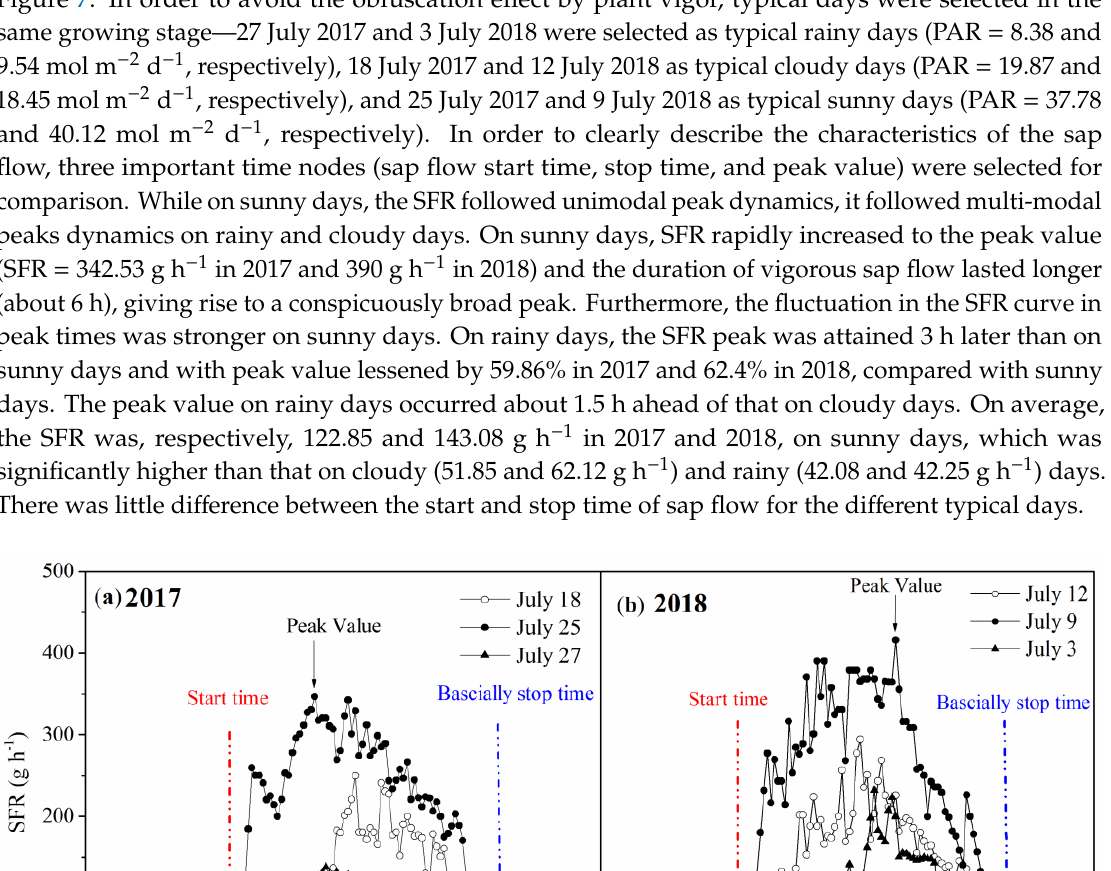
Figure 6. Plots of relationship between hourly sap flow rate (SFR) and environmental factors—( a ) photosynthetically active radiation (PAR), ( b ) vapor pressure deficit (VPD), ( c ) air temperature (T) and ( d ) relative humidity (RH) in different months in 2018. Note that the red line is the regression relationship for data in August, and the black line is that for data in other months.